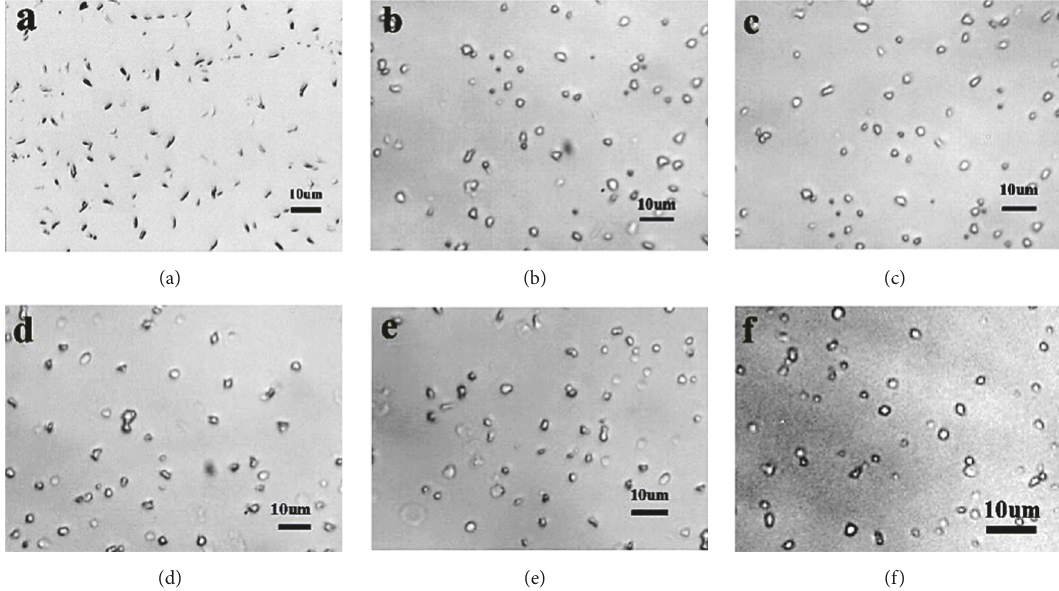
Figure 4: Optical microscopy images of the cellulose gel particles (a) prepared from cellulose solution with concentration of 2.0 wt%; (b)-(f) were for SRC-10, SRC-20, SRC-30, SRC-40, SRC-50,